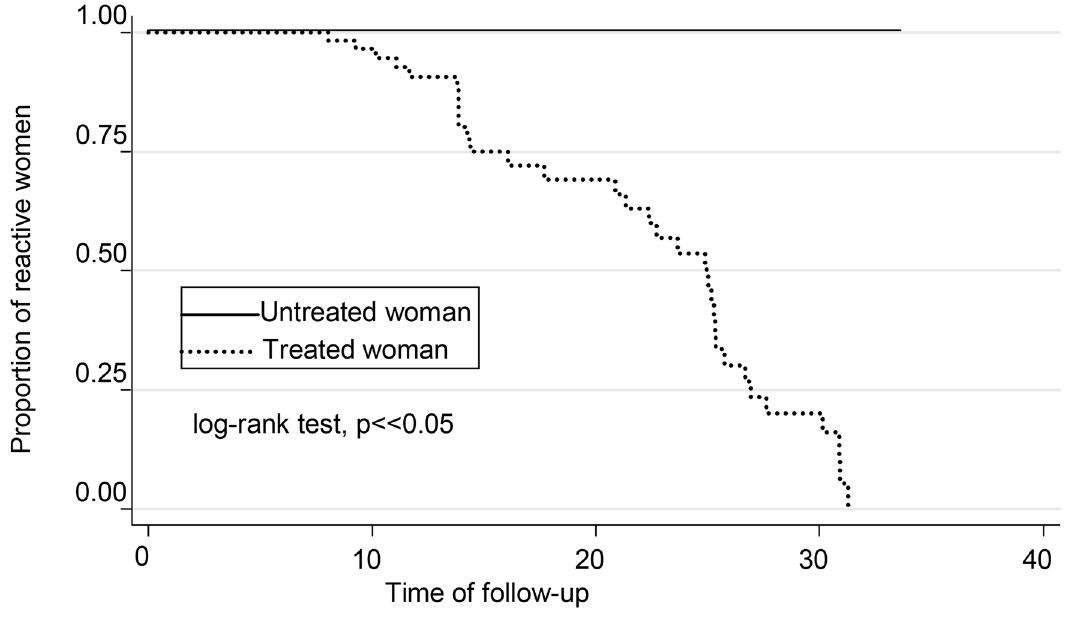
Figure 3. Kaplan-Meier curve showing serological reactivity rate during follow-up among 117 treated and untreated women. doi:10.1371/journal.pntd.0003312.g003 PLOS Neglected Tropical Diseases |